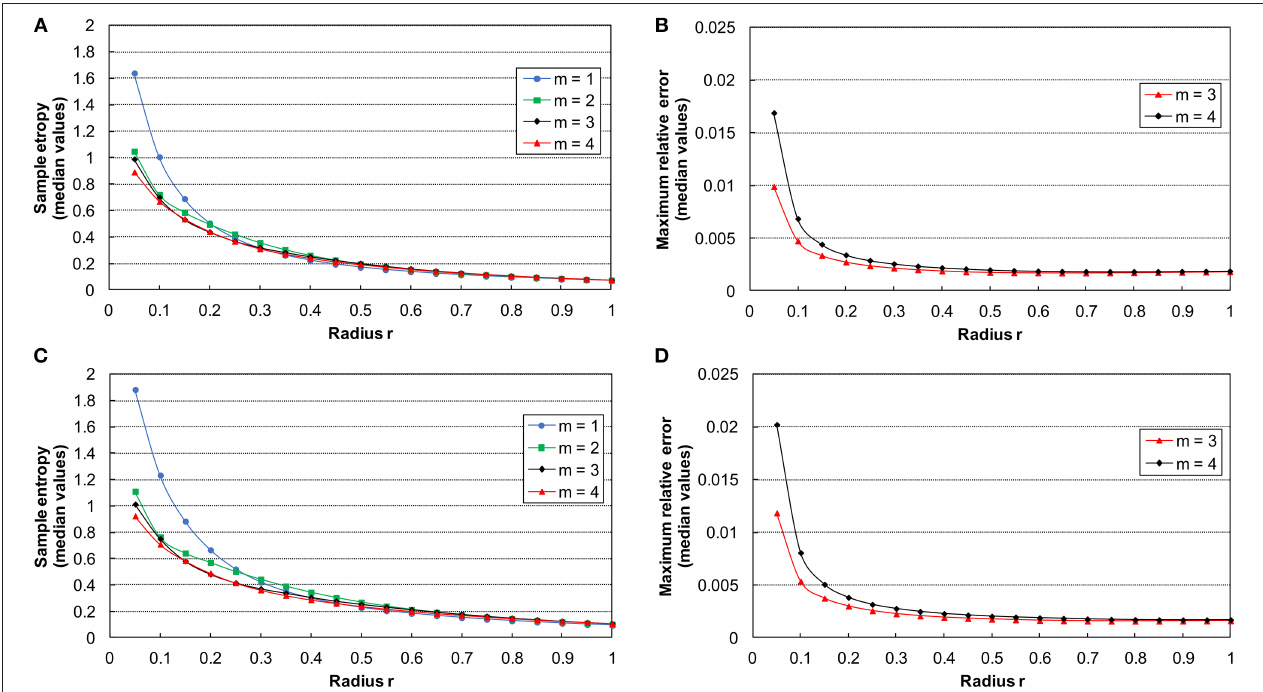
FIGURE 2 | On the left side: curves of the median sample entropy estimation as function of r and m = 1–4 for ML (A) and AP (C) time series. On the right side: curves of the median of the maximum relative error for ML (B) and AP (D) time series with m = 3 and m = 4.